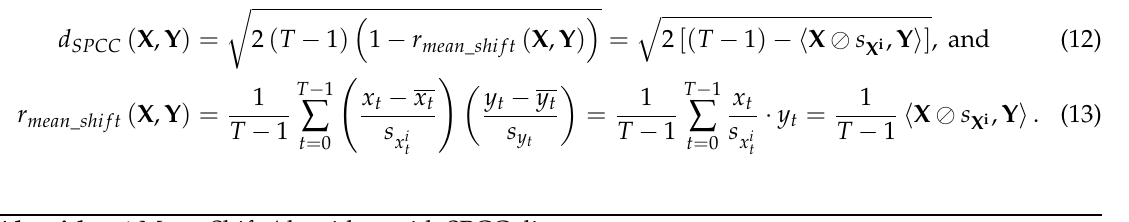
Algorithm 1 Mean-Shift Algorithm with SPCC